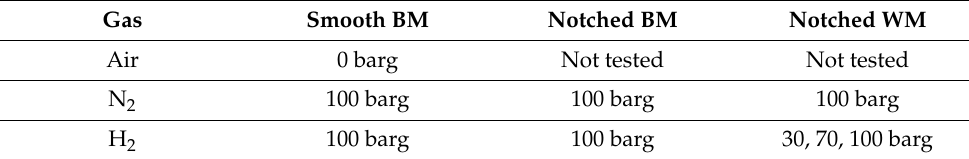
Table 2. Summary of the different subgroups of base metal (BM) and weld metal (WM) specimens. Test pressures are gauge